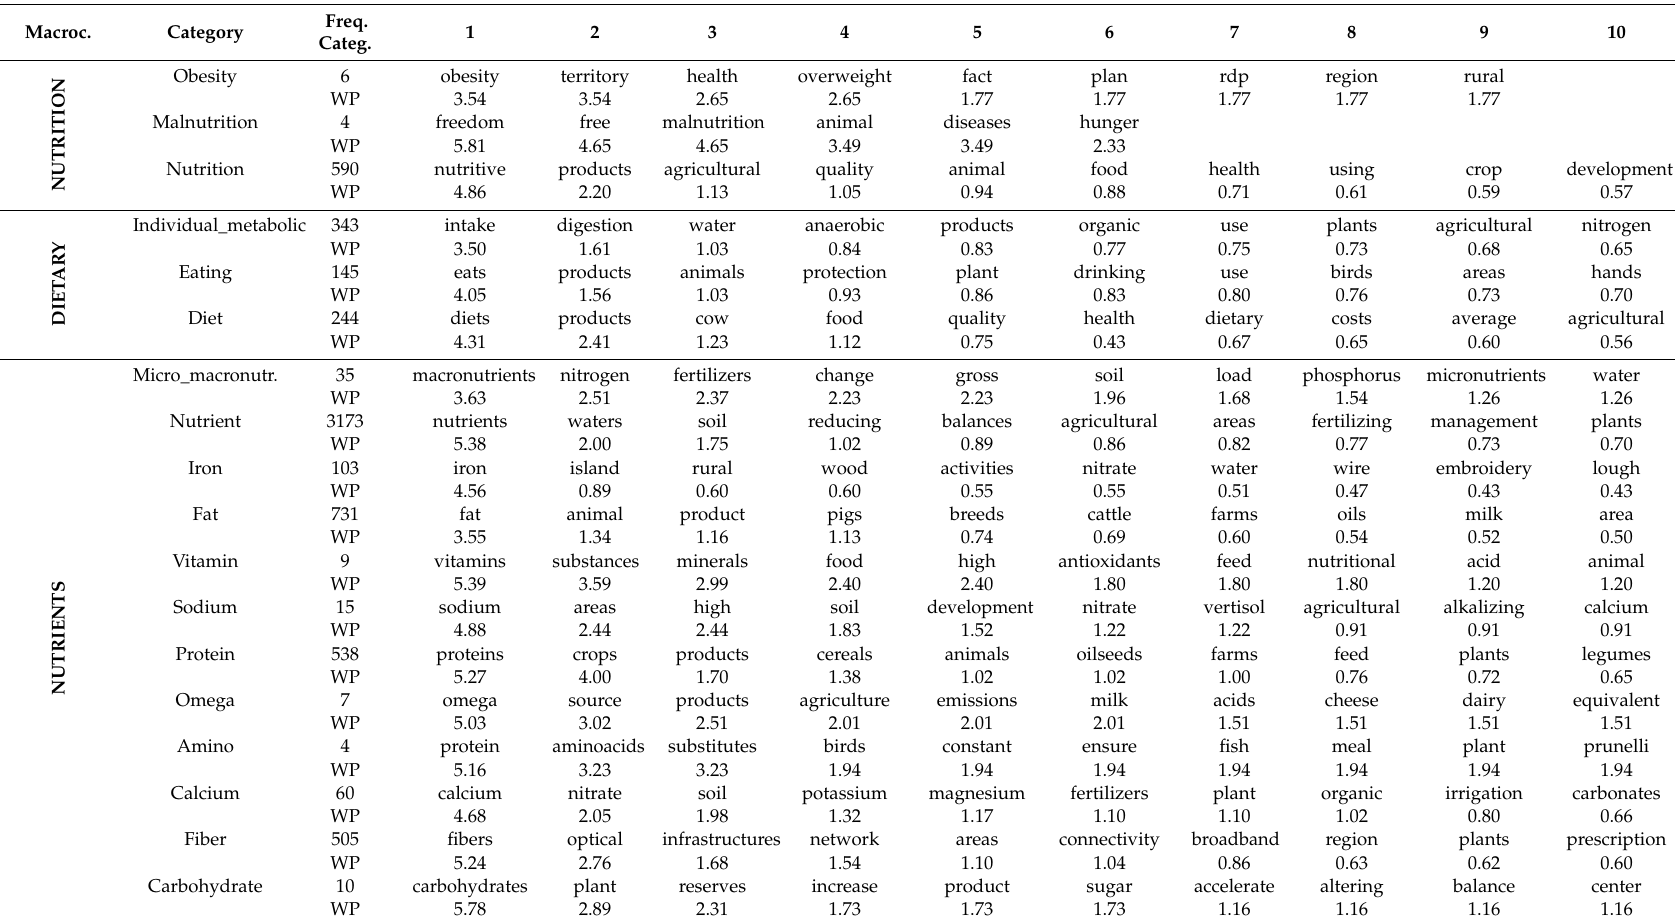
Table A6. Word frequency within single Nutrition dimension